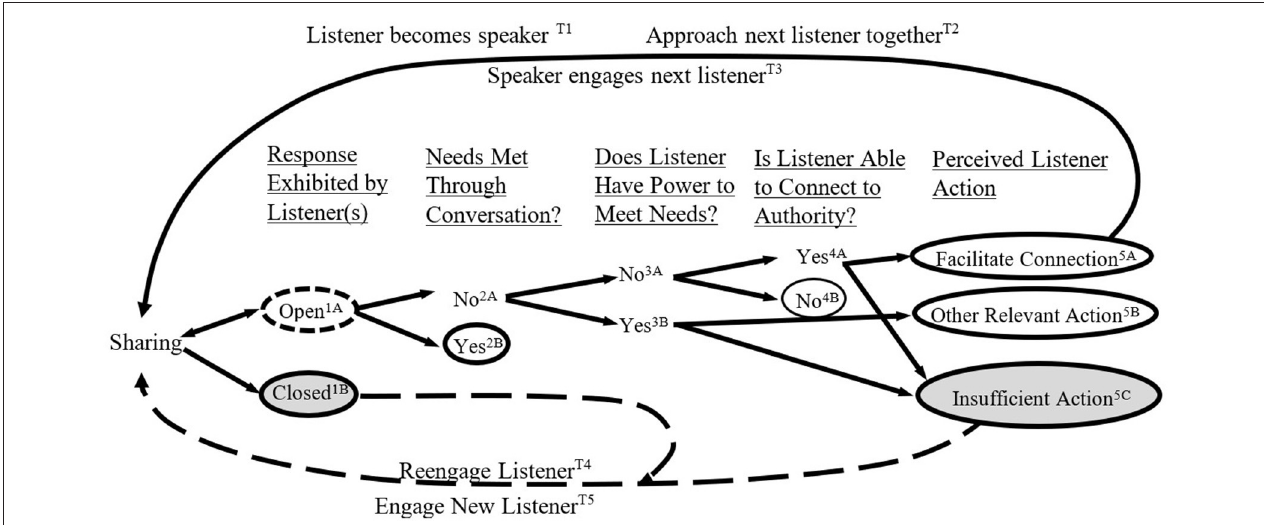
FIGURE 1 | How employees see and judge listening as listening opportunities unfold. Path ending in 1B represents “rejection;” path ending in 2B represents “conversational growth;” paths ending in 4B and 5A represent “tentative listening;” path ending in 5B represents “feeling heard through action” and path ending in 5C represents